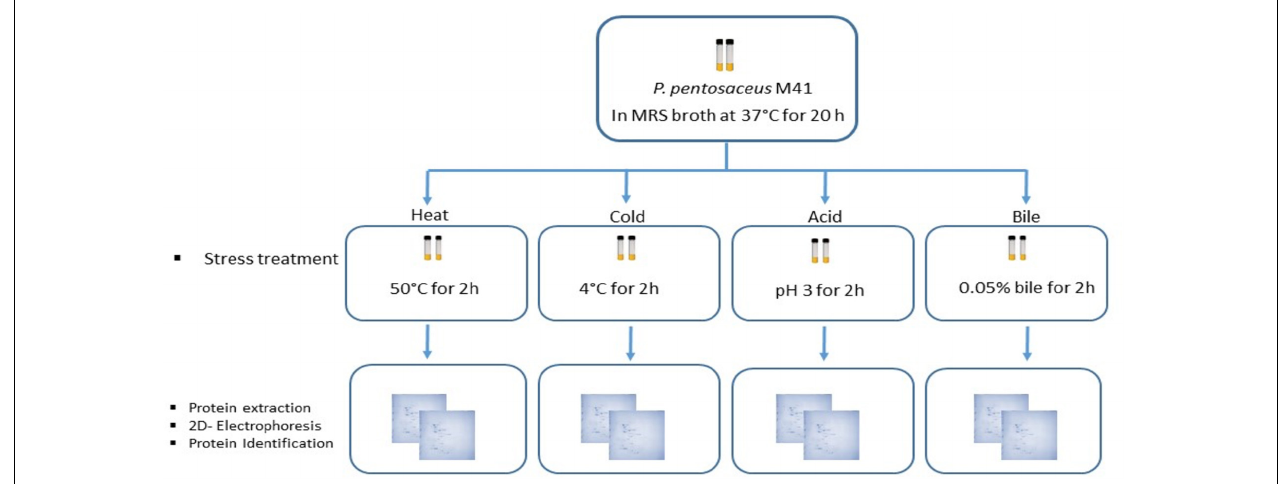
FIGURE 1 | Workflow for the study of P. pentosaceus M41 under different stress treatments and its proteomic response for identification of differentially expressed proteins.